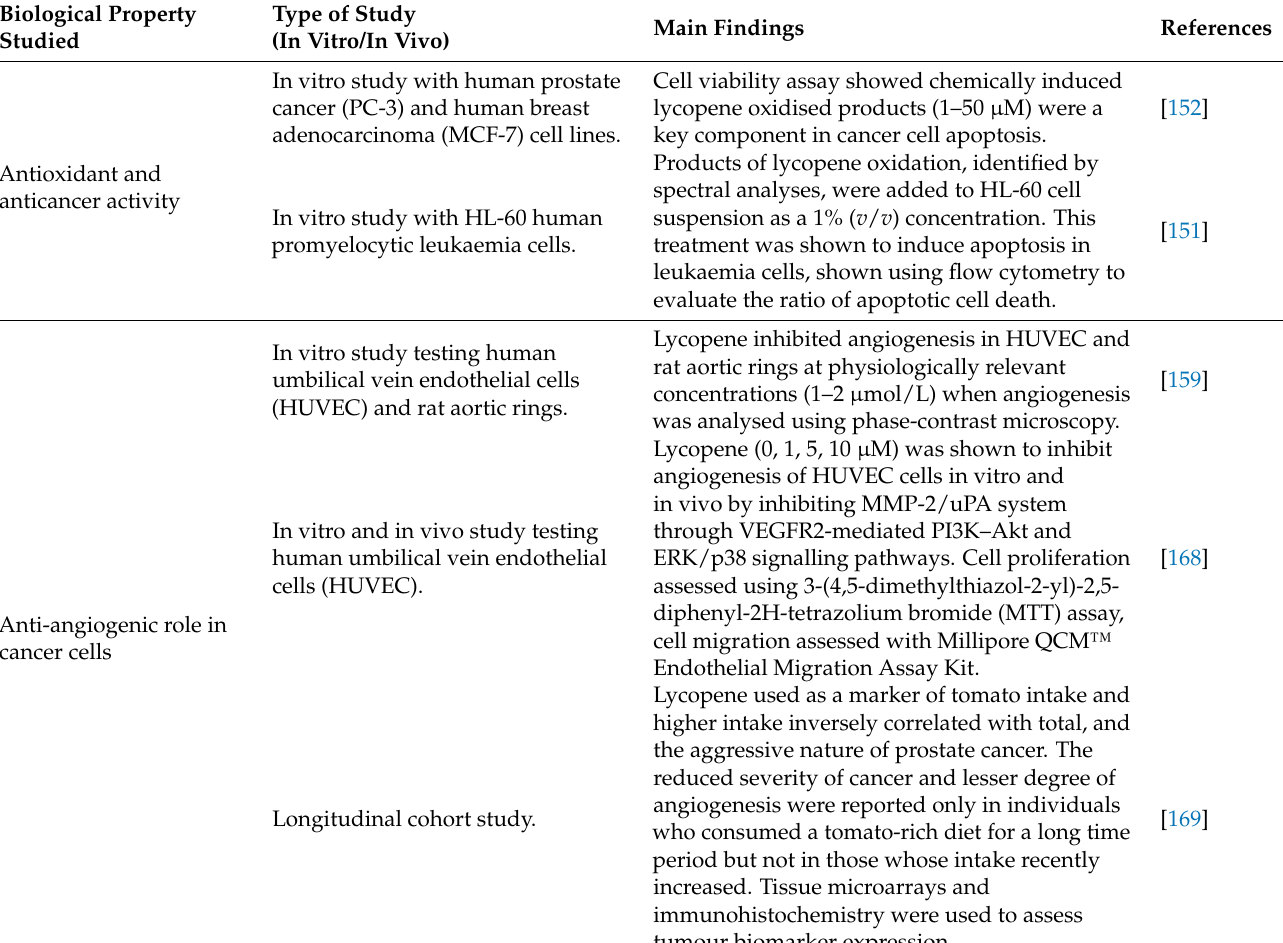
Table 2. Main findings of the effect of tomato compounds on